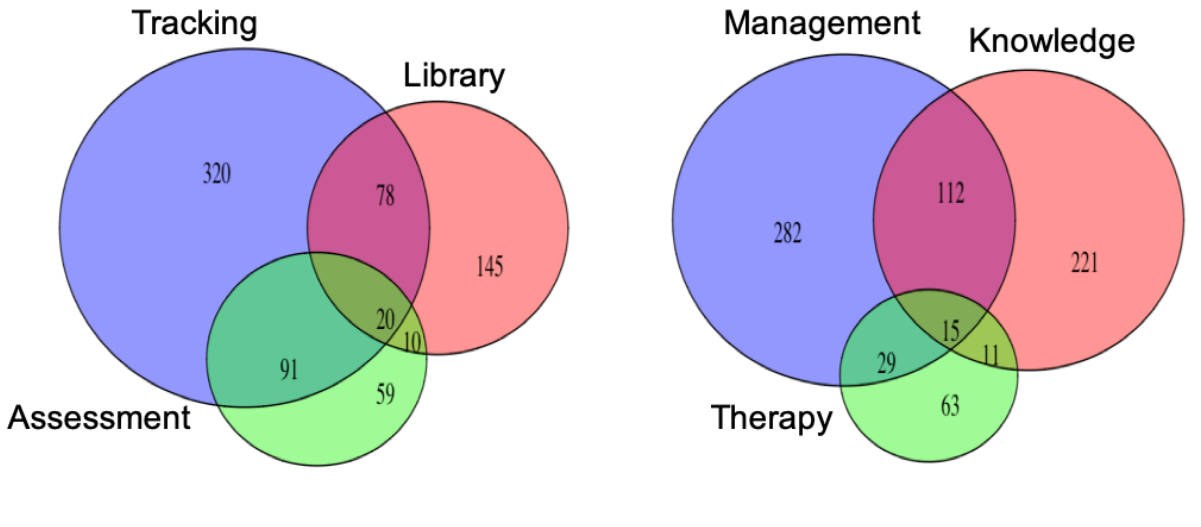
Figure 1. Comments that indicate app features being used (left) and explanations of app use and why it is beneficial (right). ‘Tracking’refers to mood tracking or journal features, ‘Library’ refers to informational resources, videos, or prompts for activities, and ‘Assessment’ refers to the depression assessment (left). ‘Management’refers to comments that indicate applying the app for self-management of moods or mental health over time, ‘Knowledge’ refers to self-knowledge or insight gained from using the app, while ‘Therapy’refers to app use in conjunction with some kind of clinical